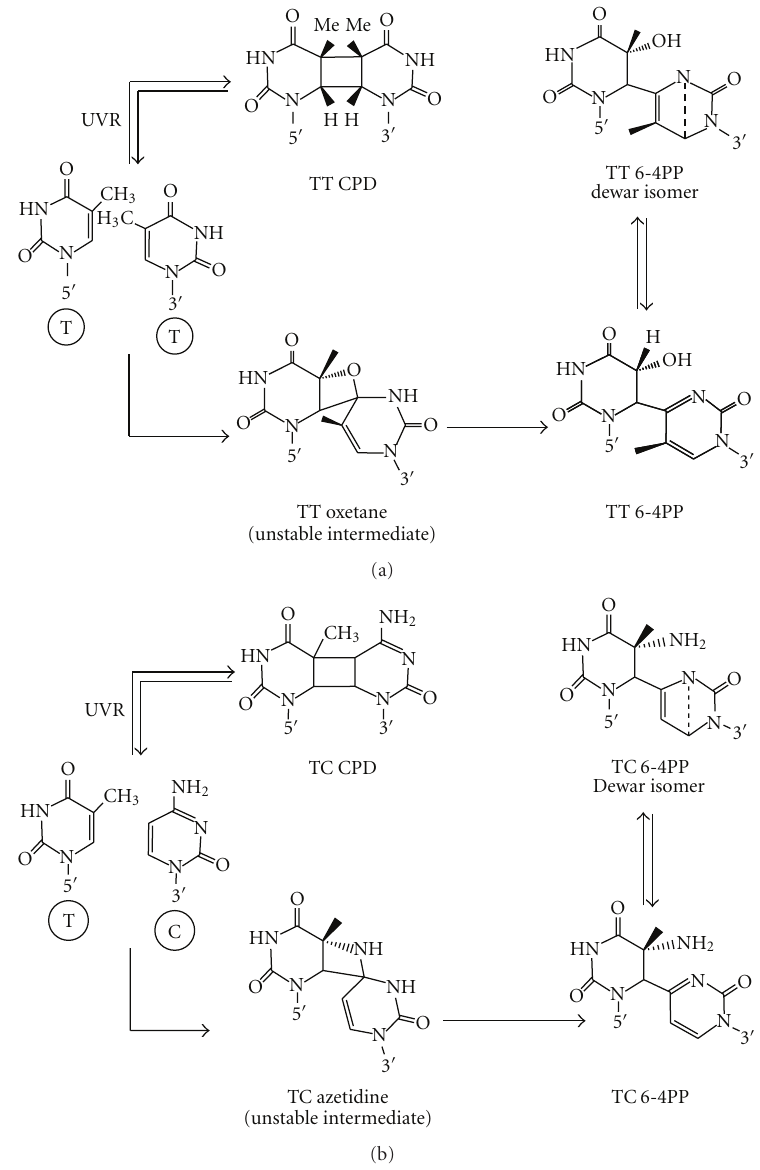
Figure 3: Pathway of UVR-induced T-T (a) and T-C (b) CPD, 6-4PPs, and their Dewar